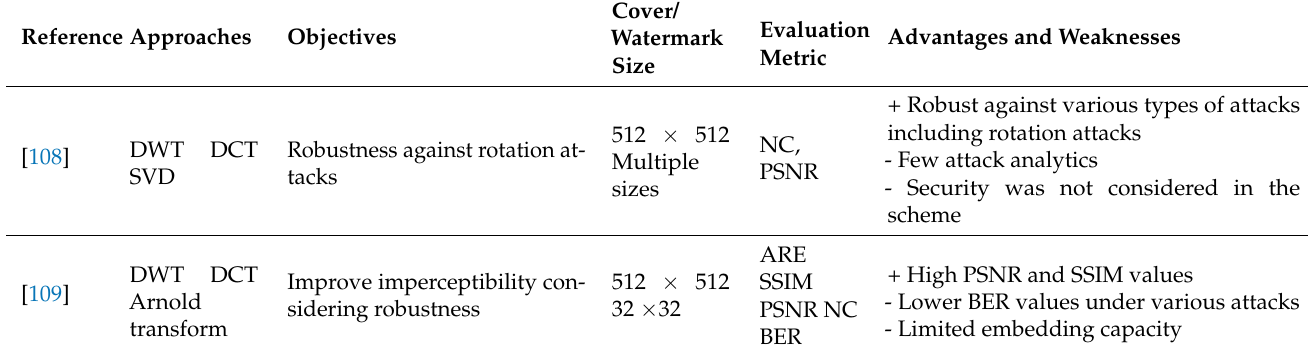
Table 3. Summary of hybrid domain-based image watermarking